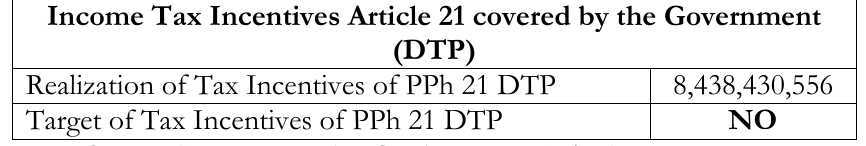
Target and Realization of Tax Incentives of PPh 21 DTP in West Bekasi KPP Pratama in